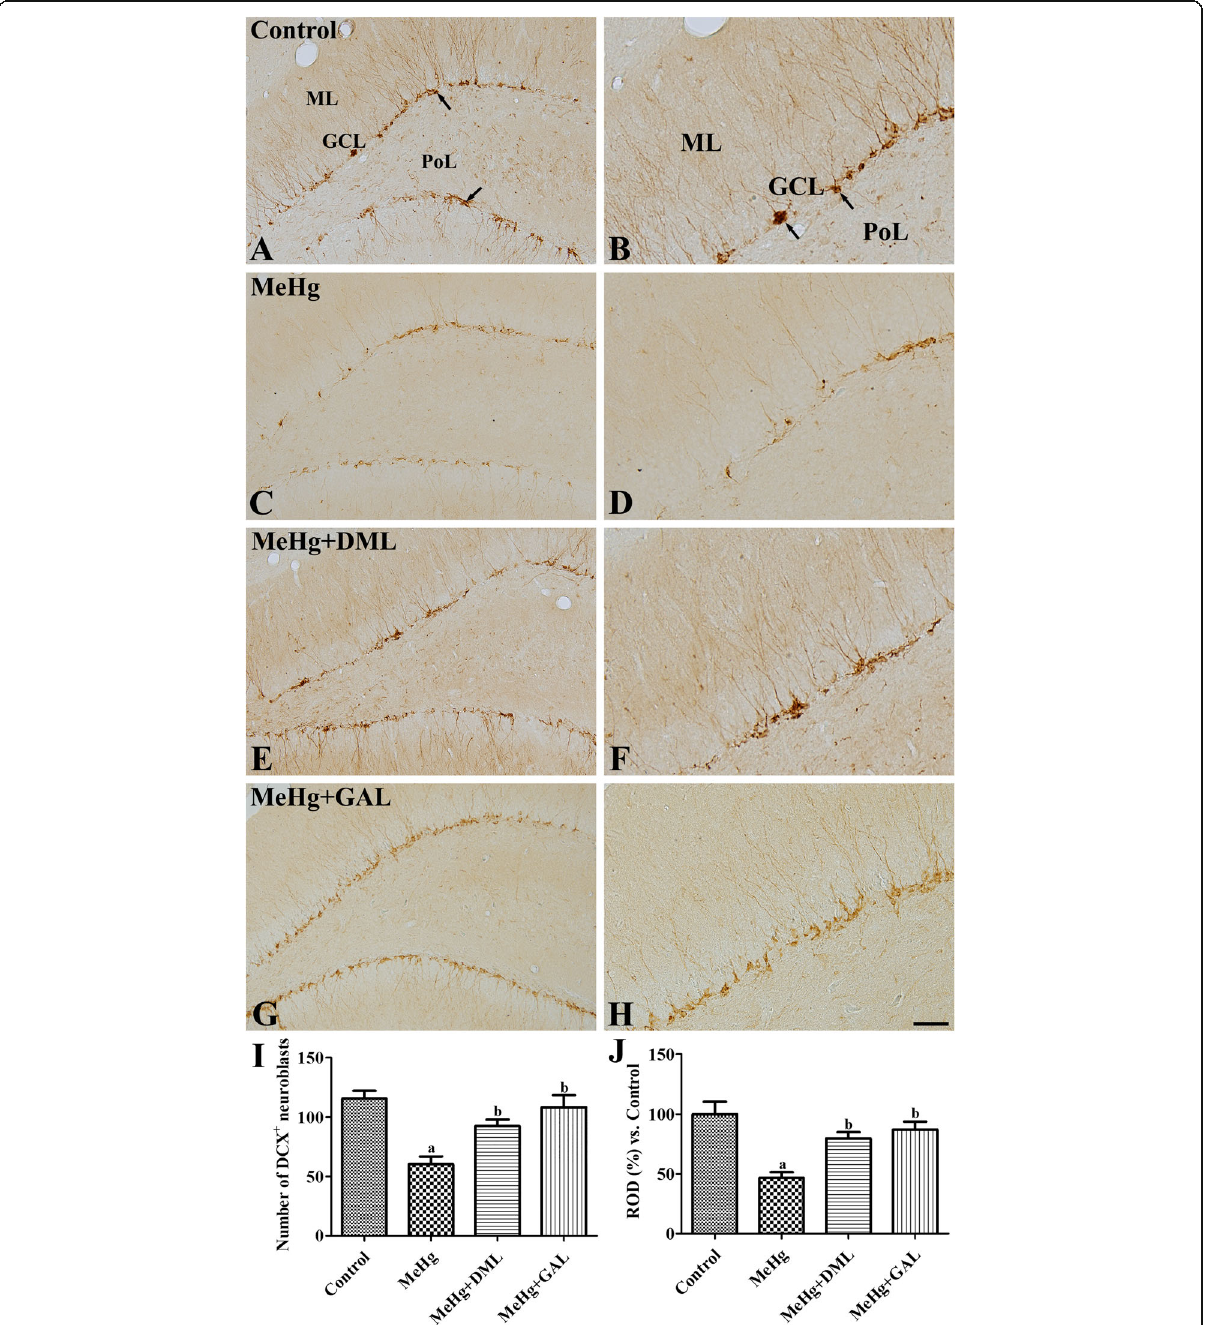
Fig. 4 Immunohistochemistry for doublecortin (DCX) in the dentate gyrus of the control group ( a and b ), dimethylmercury (MeHg)-treated group ( c and d ), Dendropanax morbifera leaf extract treated group with MeHg (MeHg+DML) ( e and f ), and galantamine (GAL) treated group with MeHg (MeHg+GAL) ( g and h ). In the control group, DCX immunoreactive neuroblasts are abundantly in the dentate gyrus. Note that DCX immunoreactive neuroblasts are few and their dendrites are poorly developed in the MeHg-treated group. In the MeHg+DML-treated group, DCX immunoreactive neuroblasts are abundant and have well-developed dendrites. GCL, granule cell layer; ML, molecular layer; PoL, polymorphic layer. Scale bar = 100 μ m ( a , c , e , and g ), 50 μ m ( b , d , f , and h ). ( i and j ): Quantitative analysis of DCX immunoreactive neuroblasts. The number per section and the relative optical densities (RODs), expressed as a percentage of the value representing the DCX immunoreactivity in the dentate gyrus of the control group, are also shown (n = 5 per group; ap < 0.05, vs. control group; bp < MeHgtreated group). Values are mean ± standard error of the